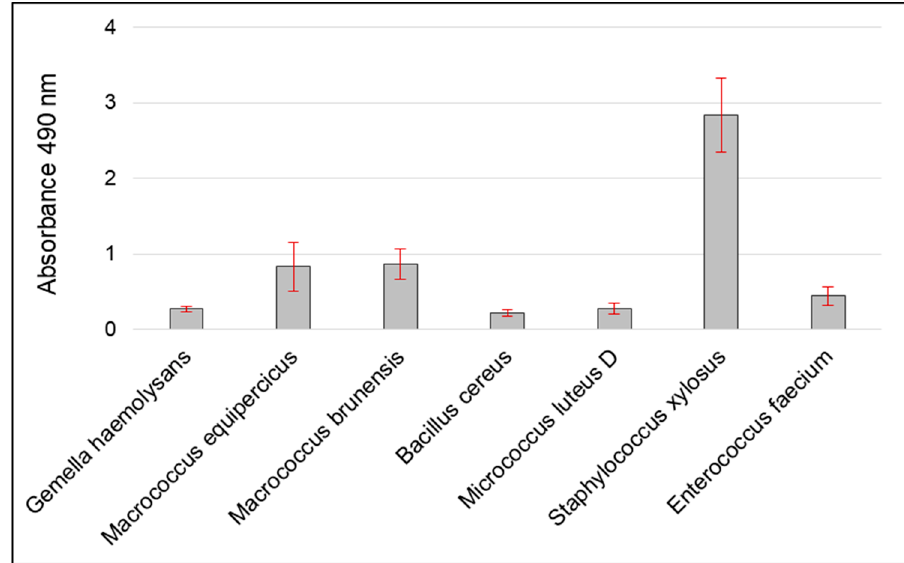
Figure 3. Biofilm formation by the isolated strains. Bars represent the standard deviation.